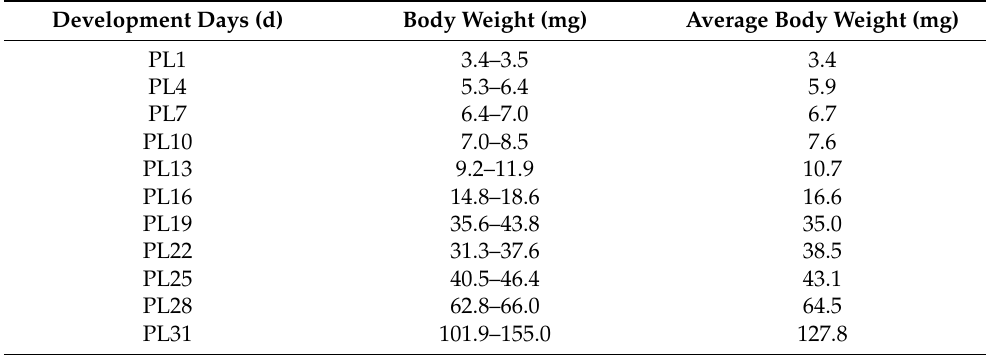
Table 1. The body weight of oriental river prawn at different developmental